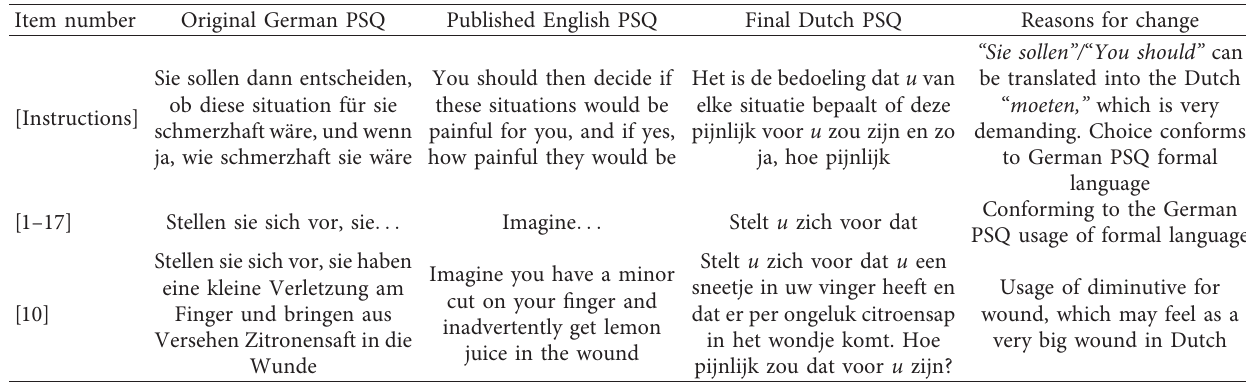
Table 1: Comparison of items in the original German PSQ with the published English PSQ for cross-cultural translation into the Dutch